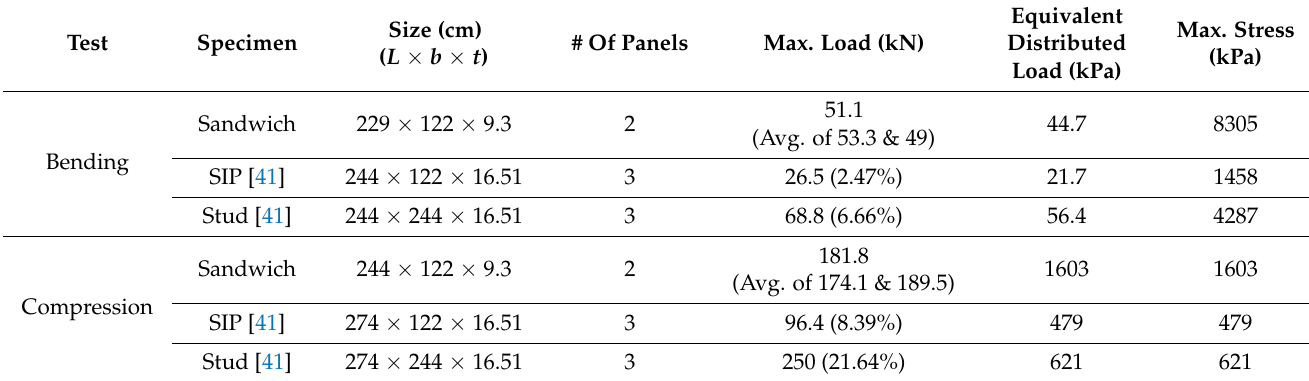
Table 2. Comparison between bending and compression results of two-layered core sandwich panel with SIP and studded walls. (Coefficient of variation, COV, shown in